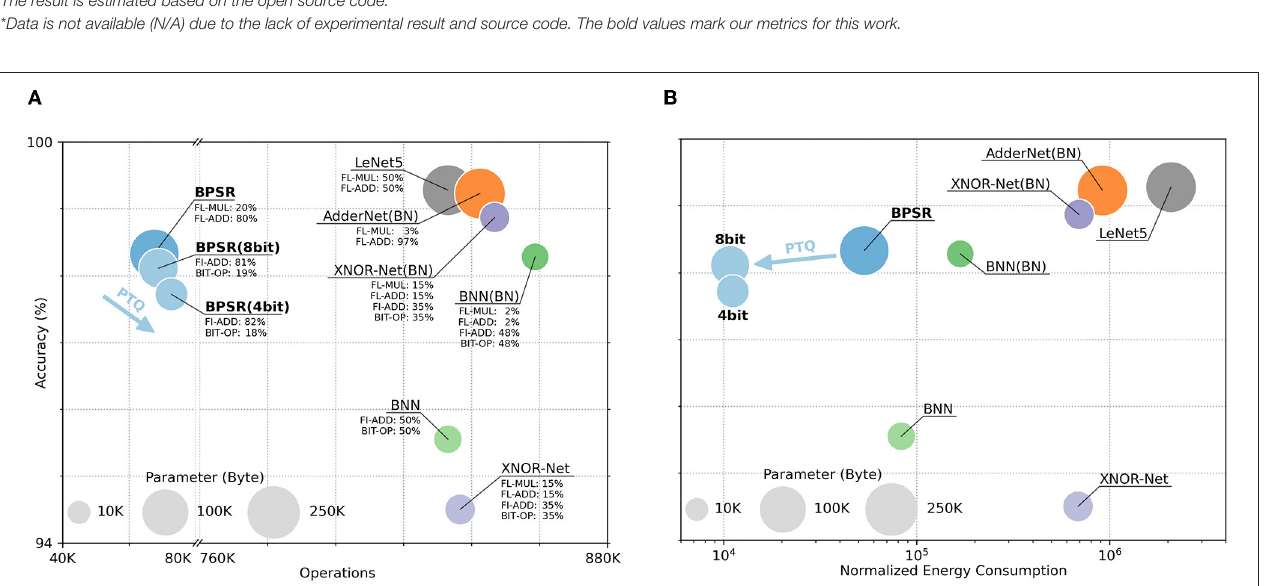
FIGURE 9 | Accuracy, operations, normalized energy consumption, and parameter size of different networks. The area of the circle represents the storage overhead of the parameters. The y-coordinate of the center represents the network accuracy. The x-coordinate represents (A) the number of operations and (B) the energy consumption of each inference. The proportions of different operations are marked in (A) . Additionally, the x-axis of (a) is folded and the x-axis of (B) is